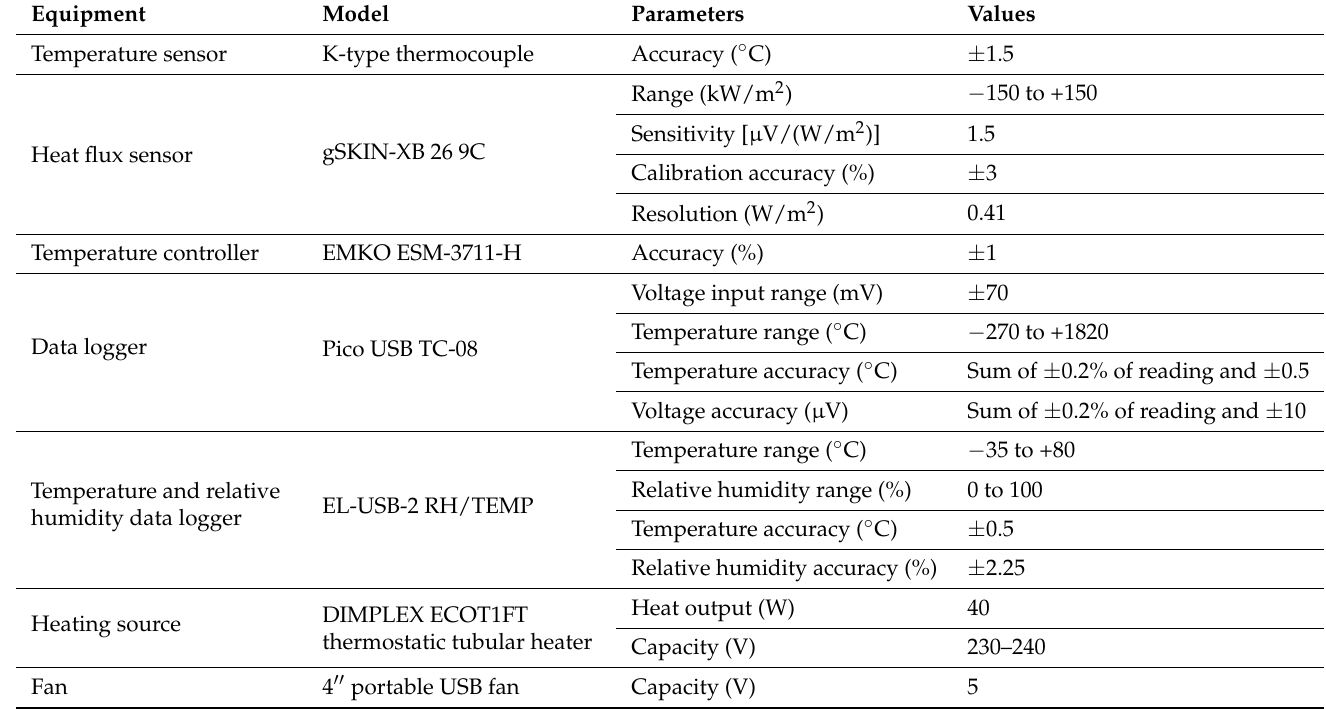
Table 5. Average values and coefficient of variation (% in parenthesis) of thermophysical properties of the sample blocks.